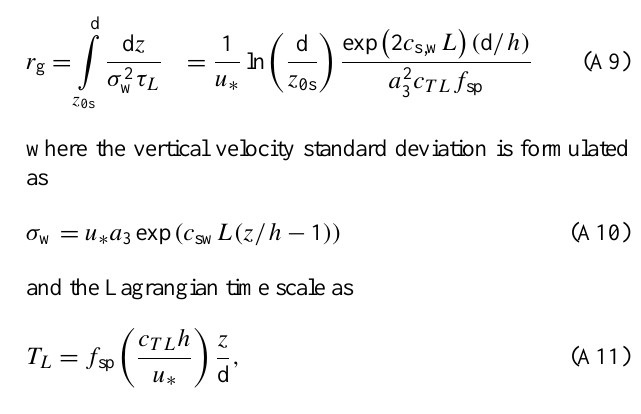
Tropical/subtropical